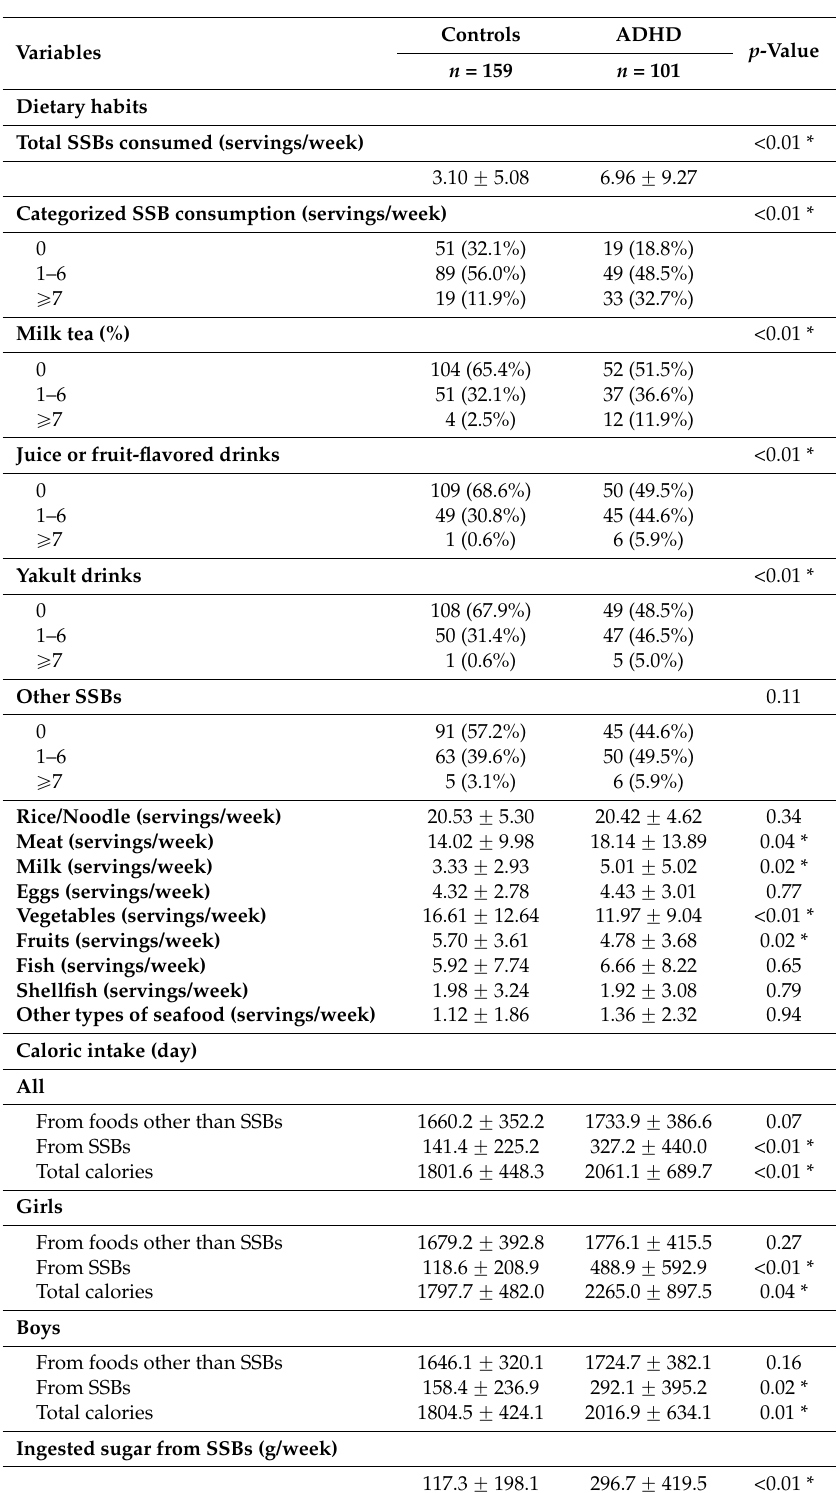
Table 2. Dietary characteristics of the study participants ( N =